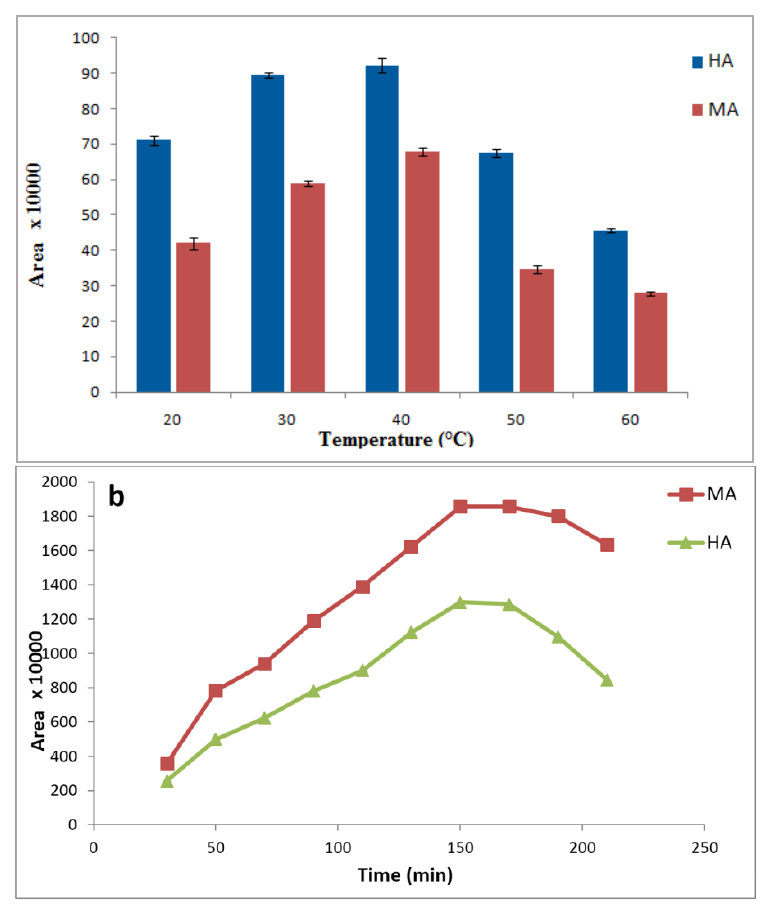
Figure 4. Effects of extraction temperature ( a ) extraction time ( b ) on extraction efficiency of HA and MA by HF-LPME. Extraction conditions: 10 mL aqueous sample solution of 1 mg·L −1 metabolites with pH = 2 containing 2 mol·L −1 NaCl; organic membrane phase: 1-octanol; 24 µL acceptor phase sodium